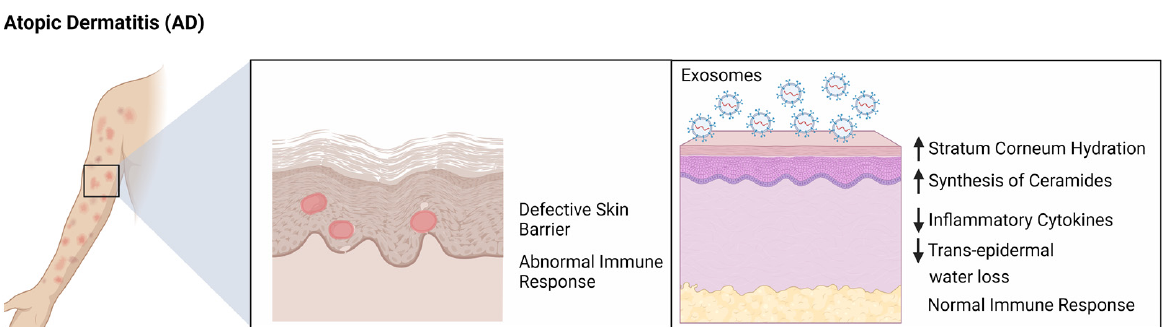
Figure 3. Role of exosomes in ameliorating atopic dermatitis (AD). ASC-exosomes improved hy- dration, lowered cytokines IL-4, IL-5, IL-13, IFN- γ , and TNF- α , reduced mast cells and DECs in lesions, and made ceramides to repair the epidermis, thereby alleviating AD. Figure was created using